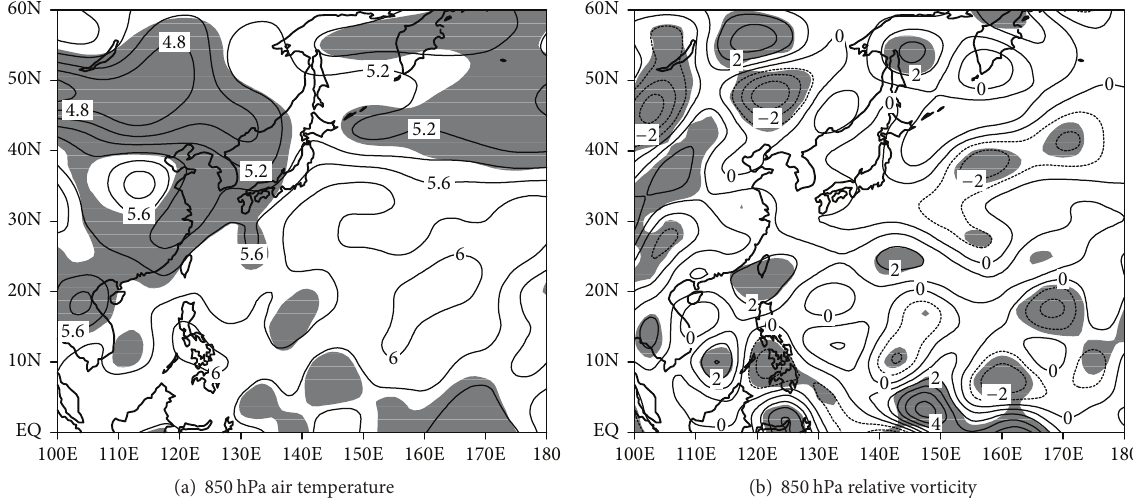
Figure 5: Same as in Figure 3, bur for (a) 850 hPa air temperature and (b) 850 hPa relative vorticity. Contour intervals are 0.2 ∘ C for 850 hPa air temperature and 1 × 10 −6 s −1 for 850 hPa relative vorticity. Shaded areas are significant at the 95% confidence level.